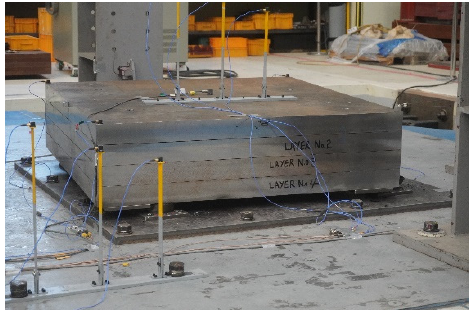
Figure 17. Shape of dummy mass on the totally ruptured LRB after testing.